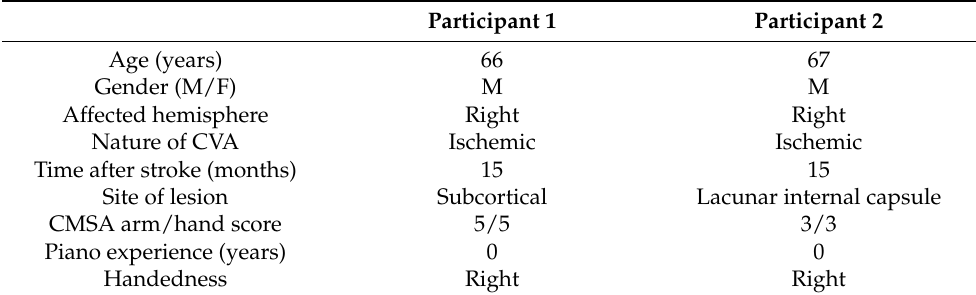
Table 1. Characteristics of stroke